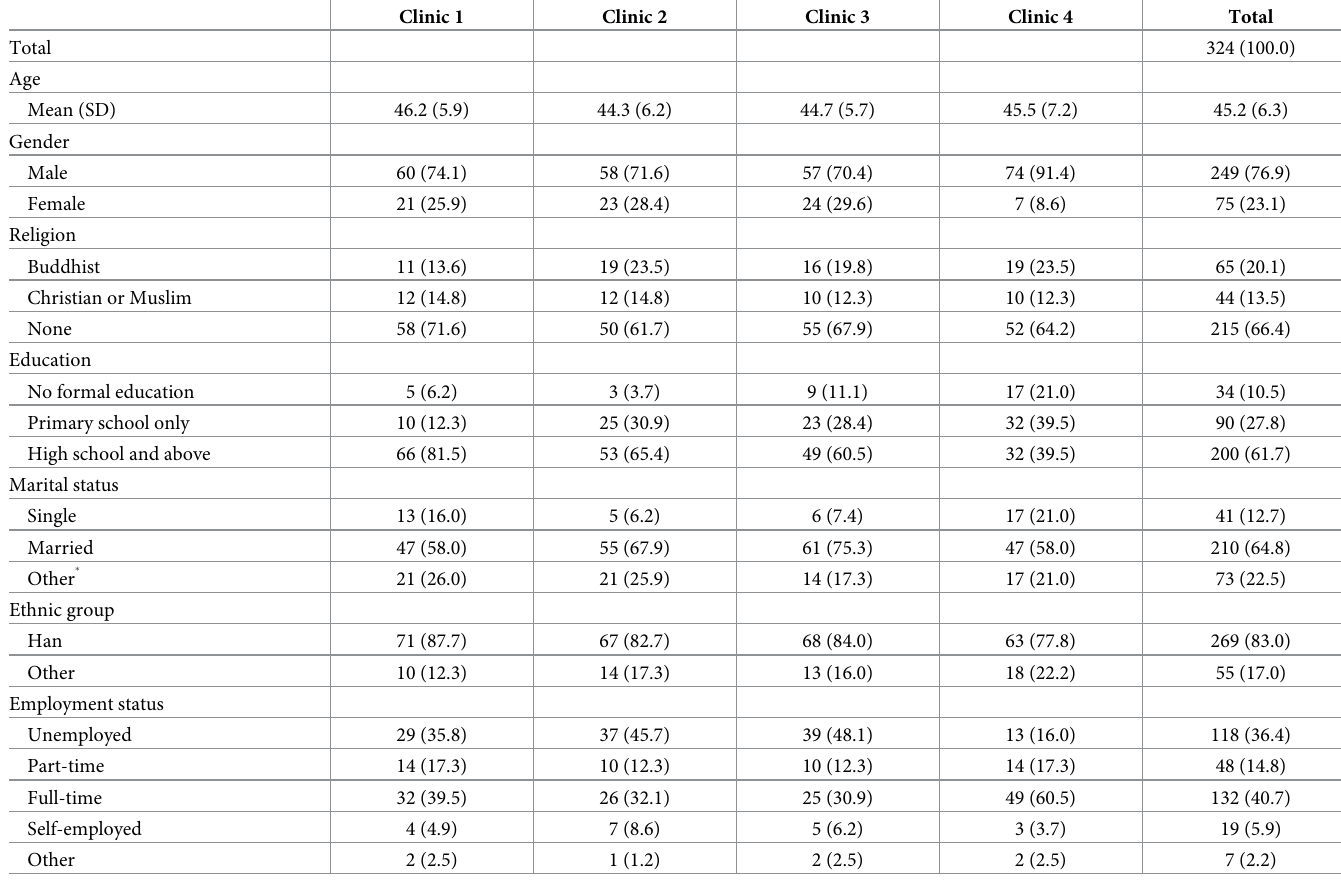
Table 1. Distribution of sociodemographic variables of subjects by clinic; N (%). Clinic 1 Clinic